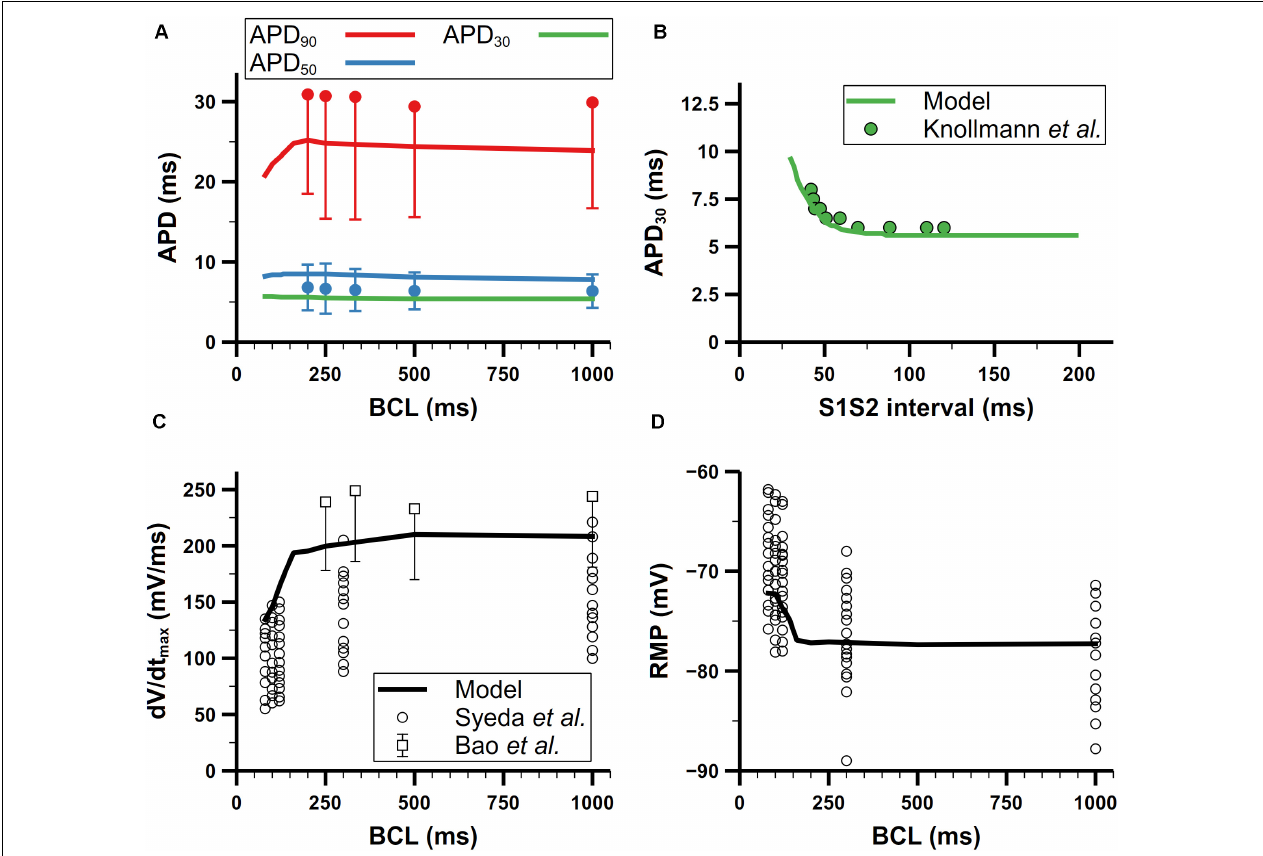
FIGURE 11 | Rate dependence of mouse atrial APs. (A) Steady-state rate dependence of simulated APDs (lines) compared with experimental data (dots) from Bao et al. (2016). Red, blue, and green represent APD 90 , APD 50 , and APD 30 , respectively. (B) Simulated APD restitution curve under an S1S2 protocol compared with experimental data from Knollmann et al. (2007). The BCL of S1 was 130 ms. (C) Rate dependence of the maximum upstroke velocity. Data from Syeda et al. are all listed without using means and error bars. (D) Rate dependence of resting membrane potential (RMP) (All data from Bao et al. in panels (A) and (C) have symmetric errors, but some of them are shown with one-side error bars for